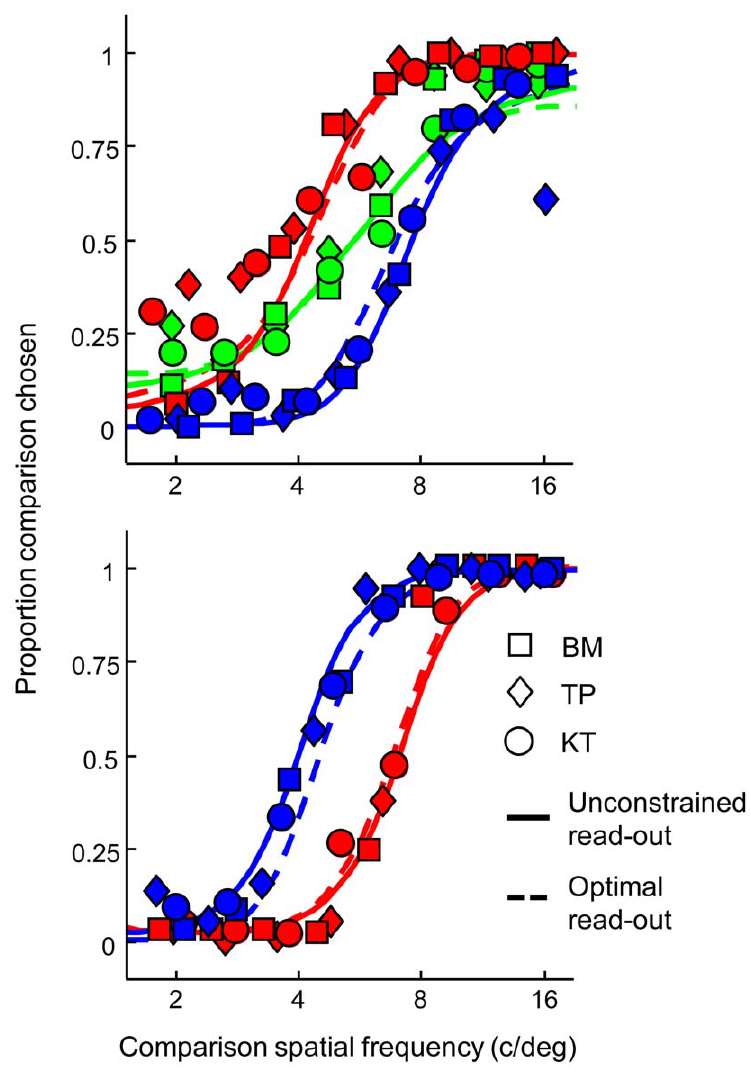
Figure 2. Spatial frequency discrimination data and model fits. Symbols indicate the pooled data of individual observers obtained in the main (top panel) and control (bottom panel) conditions of the discrimination experiment. Red, green and blue colors refer respectively to the low- pass filtered, white and high-pass filtered noise conditions. Full lines represent the fit of our population code model in which likelihood read-out function width is a free parameter. Broken lines denote the fit when narrow read-out functions are assumed in the same model. Our model accounts for the perceptual bias by assuming that the log likelihood function is read out with limited precision (full lines). When high-precision read-out is implemented, the model manages to capture the bias to a reasonable extent (broken lines) by severely reducing the amount of encoded spatial frequency information. It should be noted that the model fails to account for grating detectability in the latter case (see also Figure 3).